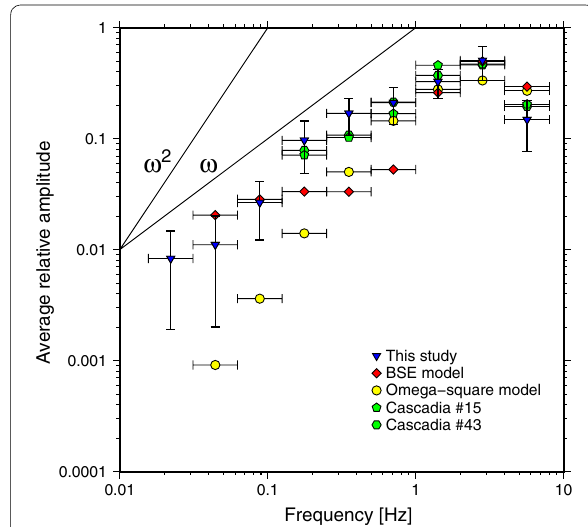
Fig. 4 Average maximum amplitude of the stacked waveforms for each frequency band. The average was taken for each of the analyzed frequency bands, except for the case that noise was dominant. Blue inverted triangles, red diamonds, and yellow squares represent the results of this study, the BSE model (Ide 2019), and the omega-square model (Aki 1967), respectively. Green pentagons and hexagons represent data from Cascadia (Bostock et al. 2015), as presented by Ide